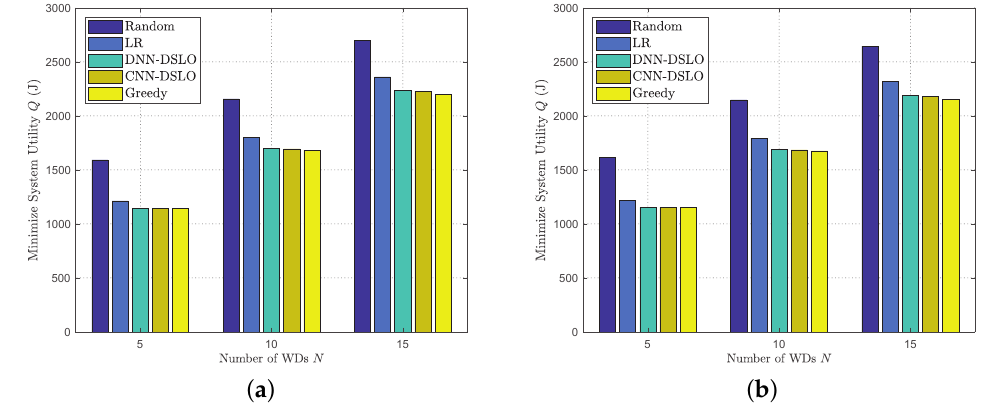
Figure 7. Comparisons of system utility performance for different offloading algorithms. ( a ) Ψ 1 ; ( b ) Ψ 2